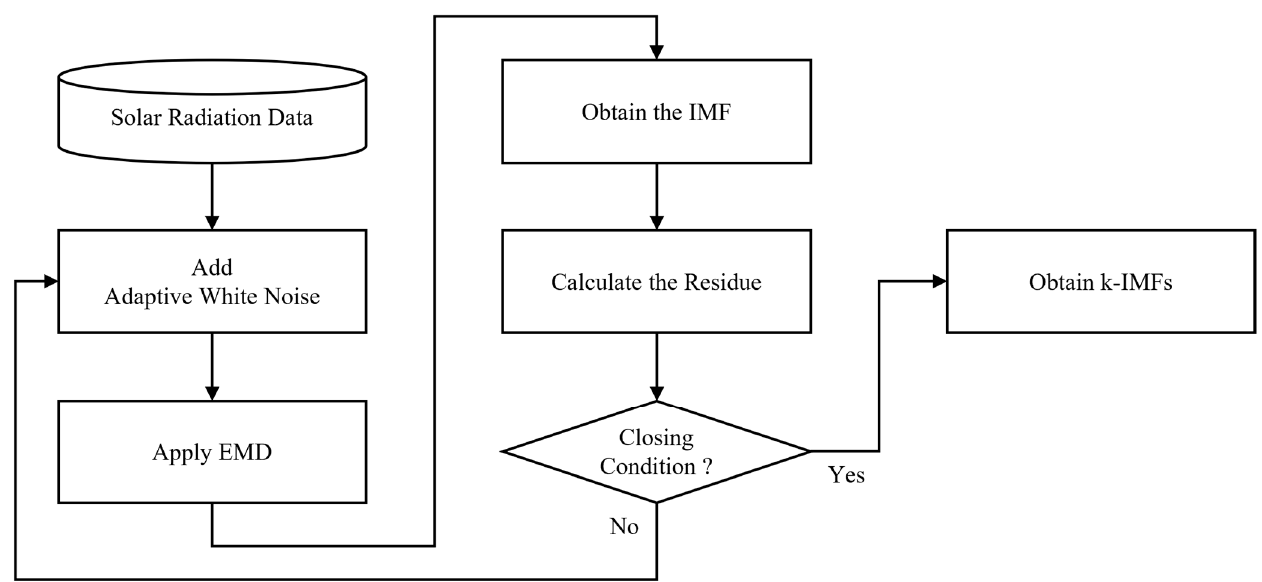
Figure 4. CEEMDAN signal decomposition process.